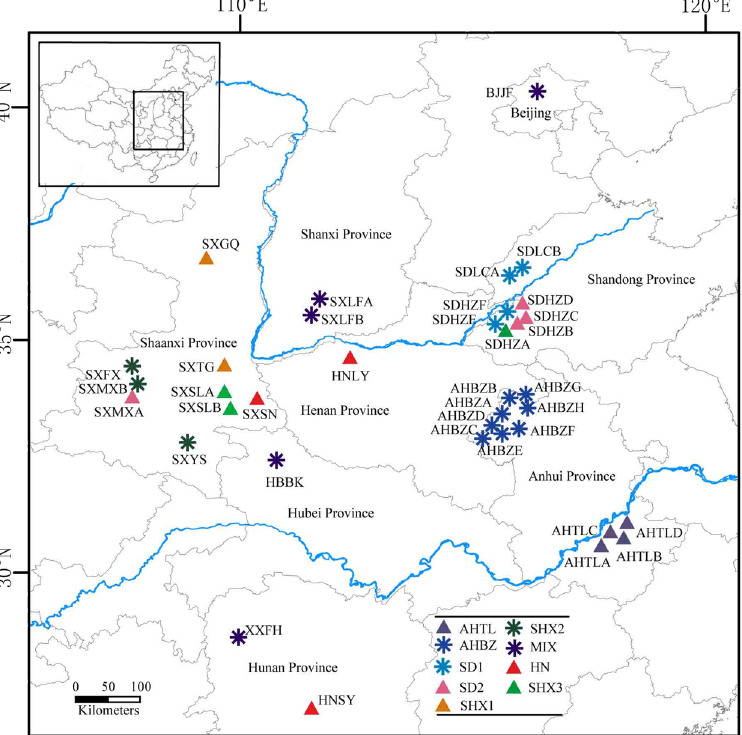
Figure 5. Geographical distribution of the 36 sampled P. ostii populations. Figure 5 was created in ArcGIS 10.0 and recombination rates ( r ) ≤ 0.3. Based on the above results, the LOD threshold was relaxed to 3.0 and mark- ers that showed segregation distortion with higher LOD values in the linkage analyses were also mapped to the linkage group without changing the order of marker linearity. The genetic distance between adjacent markers was then estimated. The graph of the genetic map with 4 SNP markers (Marker19470, Marker3373, Marker18459 and Marker36271) and 68 SSR markers was visualized using MapChart v2.3 69 . To further examine the genetic diversity and structural analyses of the 902 P. ostii individuals, 68 SSR loci on the genetic linkage map (Fig. 1) were used to perform polymorphism screening in random selected 8 P. ostii indi- viduals and 40 polymorphic markers evenly distributed all 5 linkage groups (LGs) were selected. DNA extraction and genotyping. Total genomic DNA was extracted from 30 mg of silica-dried leaf mate- rial using the DNeasy Plant Genomic DNA Kit (Qiagen, Beijing, China). The purity and concentration of the extracted genomic DNA was measured using a NanoDrop 2000 spectrophotometer at 260 nm (Thermo Scientific, USA) and adjusted to 50 ng/ μ L. PCR amplification was performed in a total volume of 10 μ L containing 1 μ L each reverse and forward primer with fluorescent labeled 6-FAM, HEX, TAMRA or ROX (Ruiboingke, Beijing, China). PCR amplification was performed with the following amplification protocol: pre-denaturation at 95 °C for 4 min, followed by 35 cycles of denaturation at 94 °C for 35 s, annealing at 47–60 °C for 35 s (different primer annealing temperatures are shown in Supplementary Table S1) and extension at 72 °C for 35 s, with a final exten- sion at 72 °C for 7 min. The PCR products were analyzed separately with an ABI 3730XL capillary sequencer along with an internal size standard (GeneScan-500 LIZ, Applied Biosystems). The SSR allele sizes were scored manu- ally using GeneMarker v2.2 (Soft Genetics, State College, Pennsylvania, USA) for all populations. Statistical analyses.